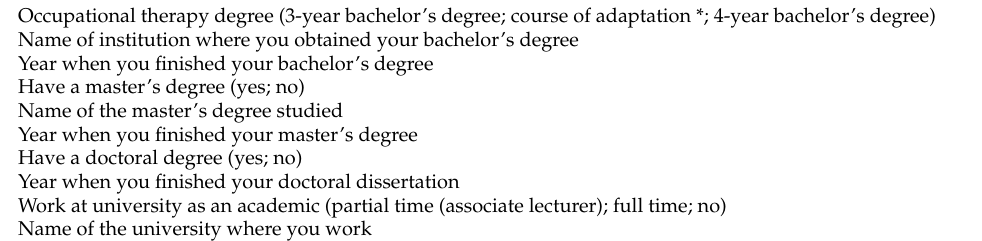
Table 4. Summary of the data on academic information collected in the HACTO-Screen